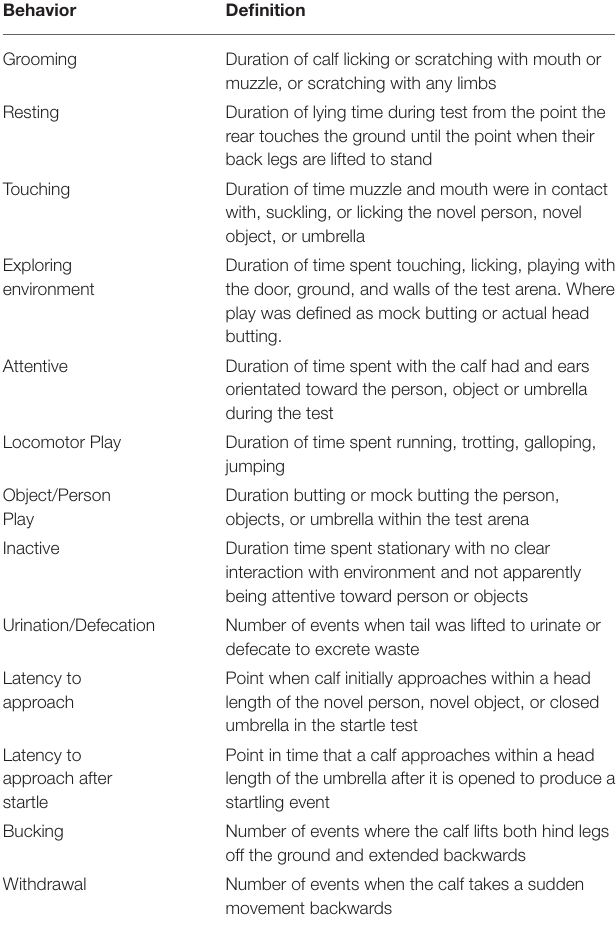
TABLE 1 | Ethogram of behaviors recorded from the video of the standardized personality tests (novel person, novel object and startle tests) from calves ( n = 27) tested individually at 24 ± 3 d of